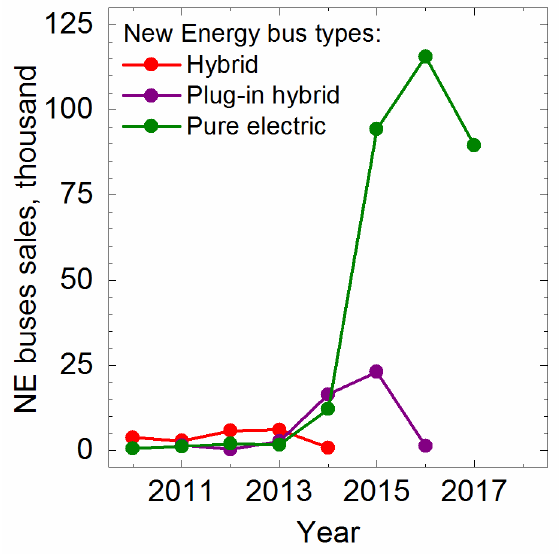
Figure 2. Annual new energy (NE) bus sales in China.